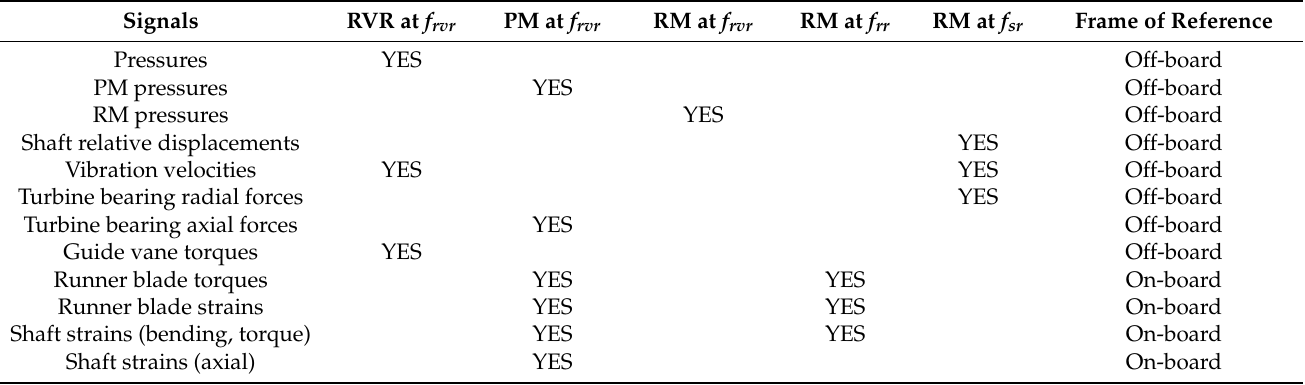
Table 2. List of the monitoring signals with their capability to detect the frequencies associated to the